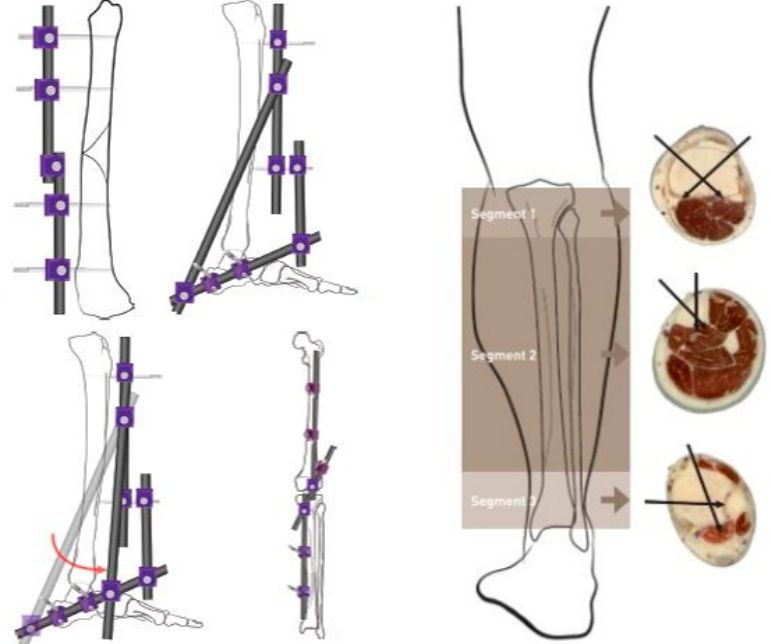
Figure 1. Left -Several types of linear fixation configurations used in tibial fractures. Right -Safe corridor for pin placement on the Tibia [24]. The image is from the Standards for the management of open fractures of the lower limb (2009) by the British Association of Plastic Reconstructive and Aesthetic surgeons and the British Orthopaedic Association and is reproduced with permission from the lead author and